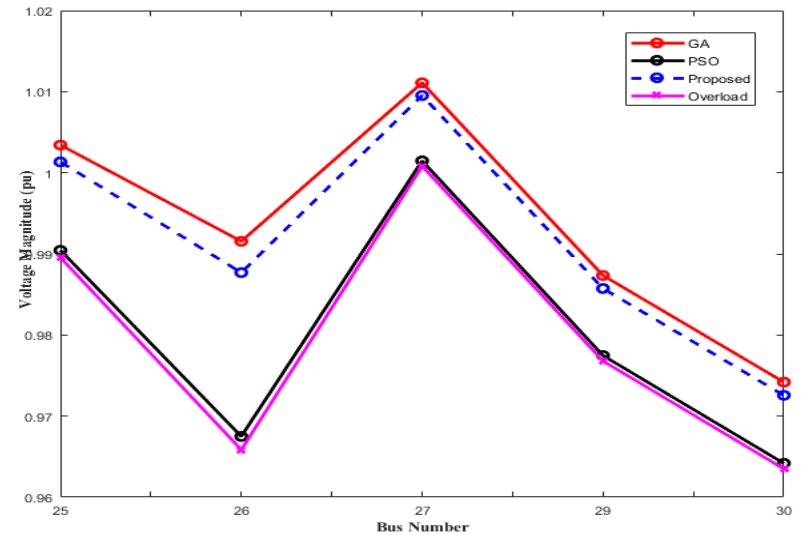
Figure 6. Voltage magnitude of the five weak buses with a loading factor of 1.6. GA: genetic algorithms, PSO: particle swarm optimization.